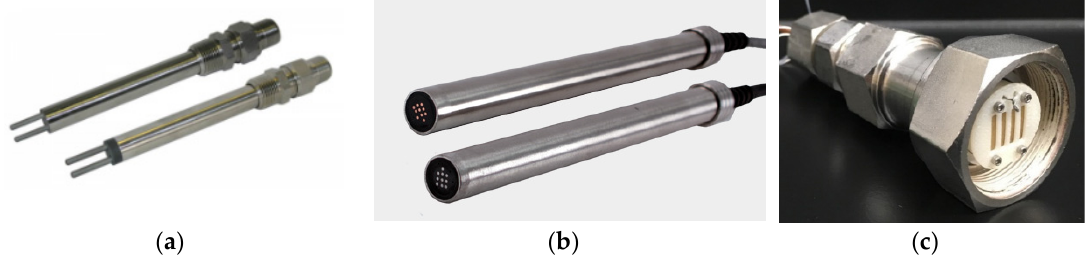
Figure 4. ( a ) Commercial 2-electrode linear polarization resistance (LPR) corrosion sensors [30] (Courtesy of Rohrback Cosasco Systems); ( b ) Coupled multi-electrode array corrosion sensors [33] (Courtesy of Corr Instruments, LLC); ( c ) Ion-conducting membrane-based advanced electrochemical sensor (AES) for simultaneous humidity and corrosion rate monitoring (Reprinted from Reference [35] with the permission of AIP Publishing).